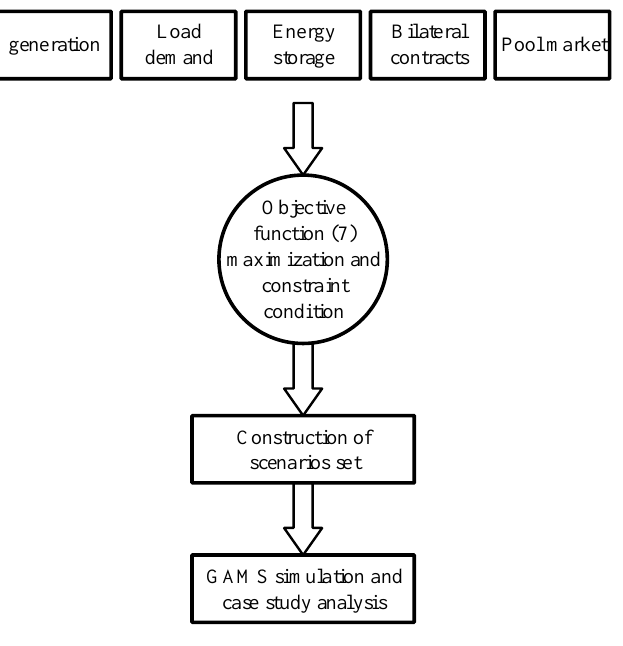
Figure 3. VPP optimization method chart.